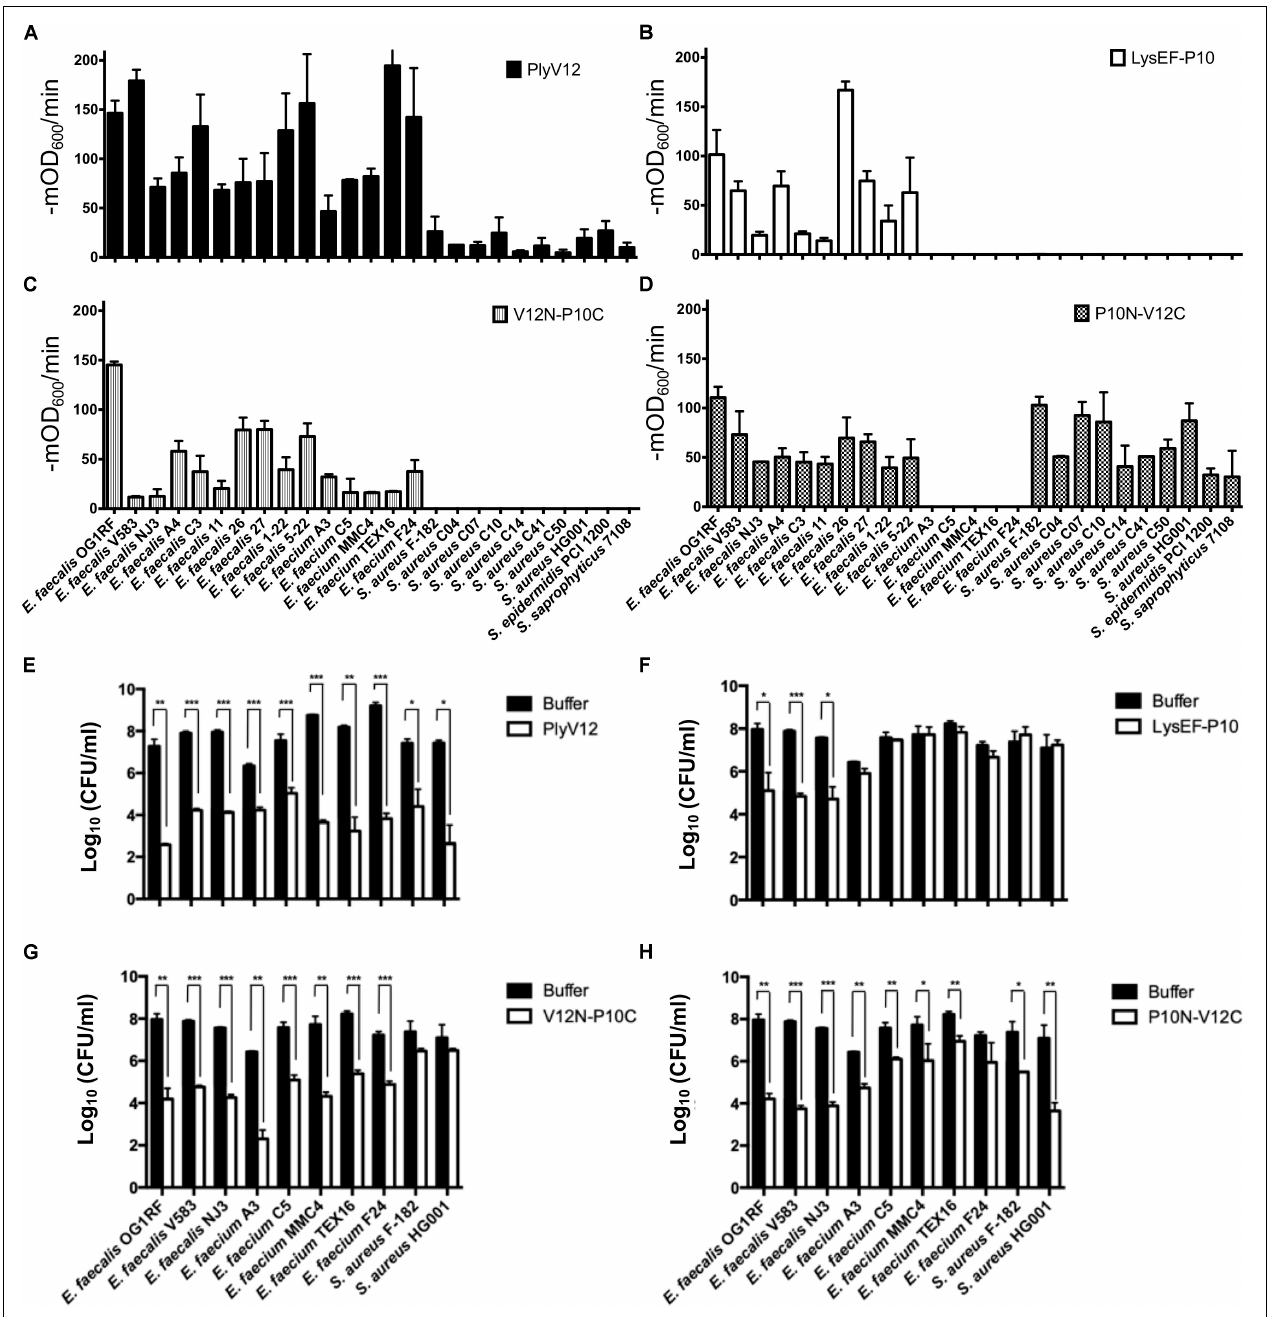
FIGURE 4 | Lytic spectra and bactericidal activities of the parent and chimeric lysins. (A–D) The lytic activities of these four lysins against 15 enterococcal and 10 staphylococcal strains were measured as the reduction in OD 600 per minute in the first 3 min. (E–H) 3 E. faecalis , 5 E. faecium and 2 S. aureus strains were treated with the four lysins under their respective optimal conditions. The number of residual CFU in each treatment was determined by plating 10-fold serial dilution and compared to that of buffer-treated controls by a two-tailed Student’s t -test with Welch’s correction. * P < 0.05; ** P < 0.01; *** P < 0.001. Experiments were done in biological triplicate; error bars represent standard